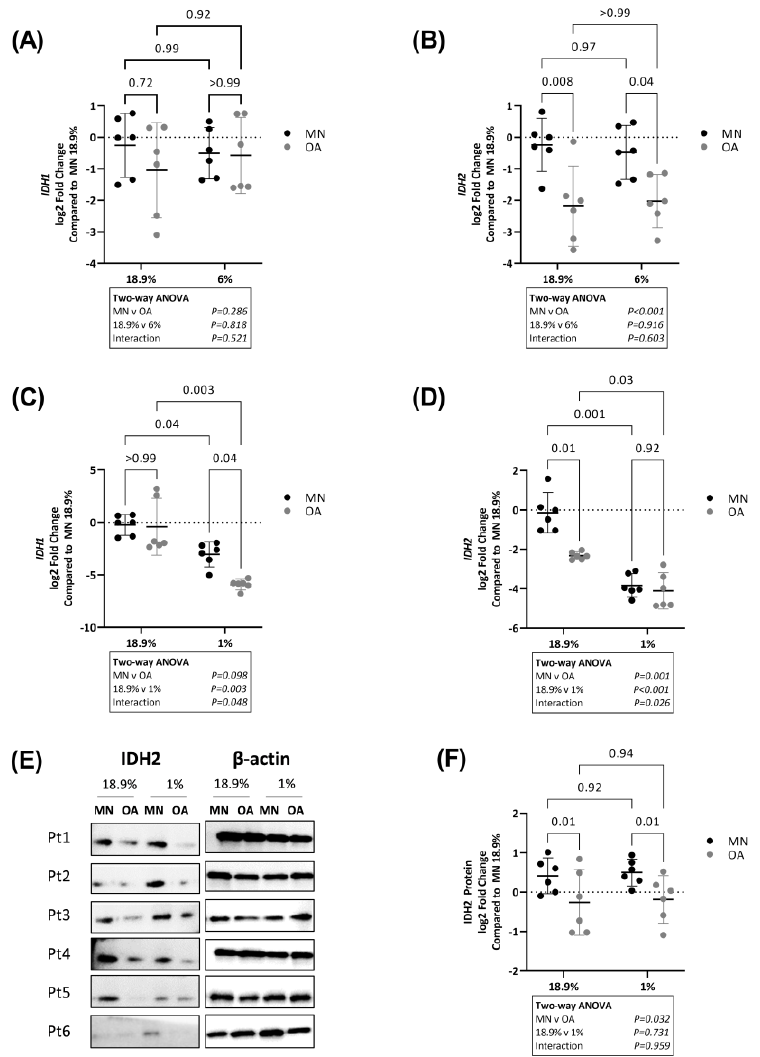
Figure 8. Expression of IDH1 and IDH2 in OA chondrocytes and chondrocytes from macroscopically normal cartilage maintained in 18.9% compared to 6% or 1% oxygen. Paired samples of human chondrocytes isolated from macroscopically normal (MN) and osteoarthritic (OA) cartilage regions within OA joints from six patients were plated in duplicate plates. One plate was transferred to a standard tissue culture incubator (18.9% oxygen) and the other transferred to a hypoxia incubator maintained at either 6% or 1% oxygen for 24 h. Chondrocytes from a different six patients were used to compare the effects of 18.9% vs. 1% oxygen than those used to compare the effects of 18.9% vs. 6% oxygen. Comparison of RNA levels (measured by qPCR) of ( A ) IDH1 and ( B ) IDH2 in cells maintained in 18.9% vs. 6% oxygen and ( C ) IDH1 and ( D ) IDH2 in cells maintained in 18.9% vs. 1% oxygen. ( E ) Western blots showing IDH2 protein levels and ( F ) quantification of IDH2 protein expression using band densitometry in OA chondrocytes and chondrocytes from MN cartilage maintained in 18.9% vs. 1% oxygen. (Note: β-actin for this figure is the same as that for Figure 7D since both proteins were stained on the same blot). Pt = patient. Data shown are mean ± 95% CI. All data were analysed by two-way ANOVA. Statistically significant differences between groups following post hoc testing are shown on graphs. p < 0.05 was considered statistically significant. Similar to IDH1 , RNA levels of IDH2 were lower in chondrocytes from both cartilage regions when maintained in 1% oxygen compared to 18.9%. However, the magnitude of the decrease was greatest in chondrocytes from MN cartilage compared to OA chondro- cytes and there was no longer a significant difference in IDH2 expression between